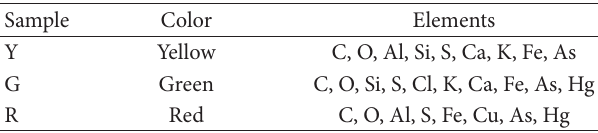
Table 2: Results of surface analysis by